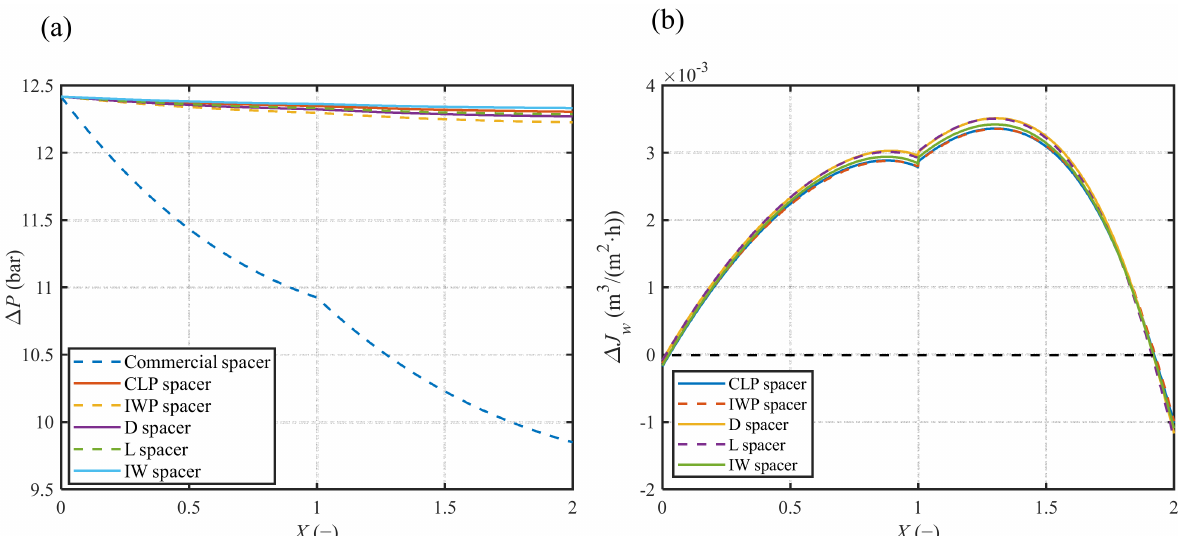
Figure 5. ( a ) The transmembrane pressure, ∆ P (bar), and ( b ) difference value of water permeation flux between TPMS-based spacers and commercial spacer, ∆ J w (m 3 /(m 2 · h)), for the whole membrane systems from inlet to outlet. Different colors represent commercial, CLP, IWP, D, L, and IW spacer- filled channels, respectively.